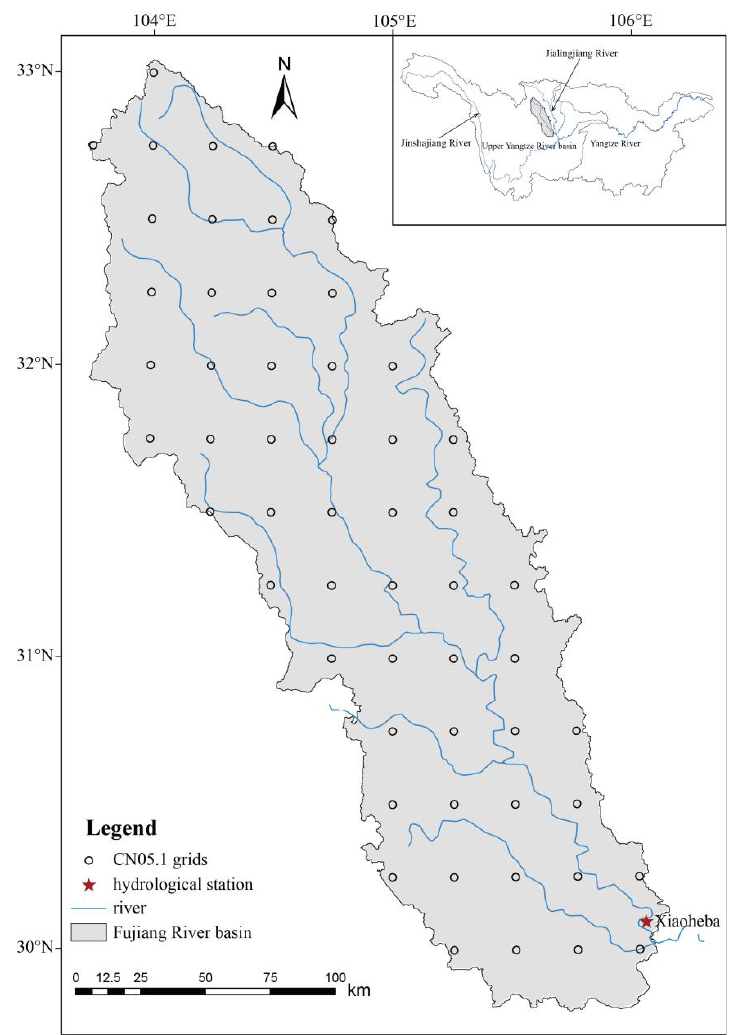
Figure 1. Location of the Fujiang River in the Yangtze River basin, and climate forcing data CN05.1 grid nodes (black hollow circle) and discharge station (red pentagram).